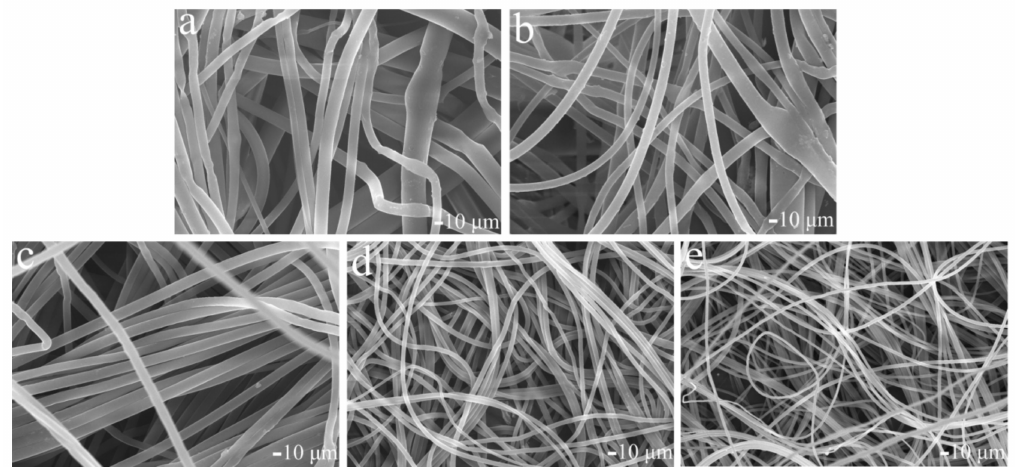
Figure 9. SEM images of melt electrospun fibers at di ff erent voltages: ( a ) 20 kV, ( b ) 25 kV, ( c ) 30kV, ( d ) 35 kV, and ( e ) 40kV.